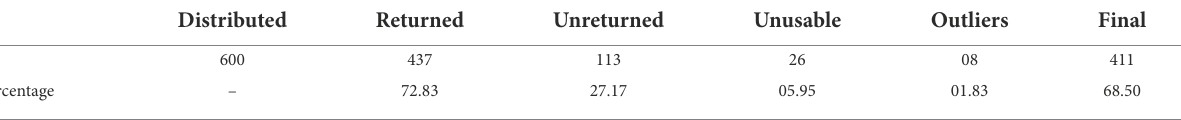
TABLE 1 Data cleaning, outliers, and response